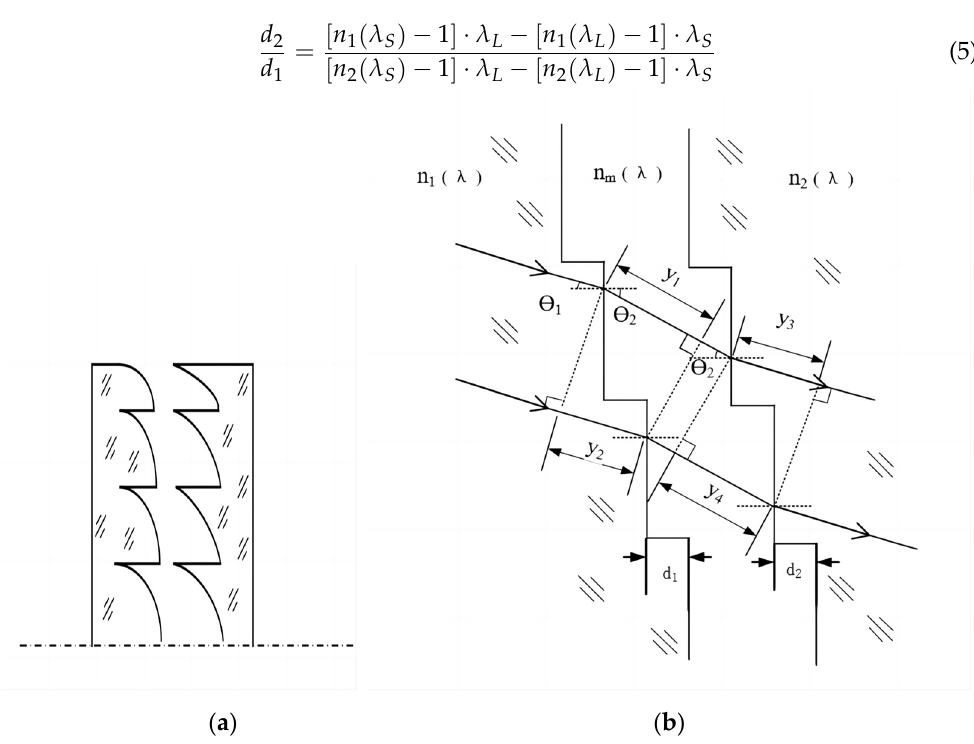
Figure 2. Schematic of a double-layer DOEs: ( a ) structure; ( b ) operating principle, showing light incident at an angle θ 1 on the internal structure.